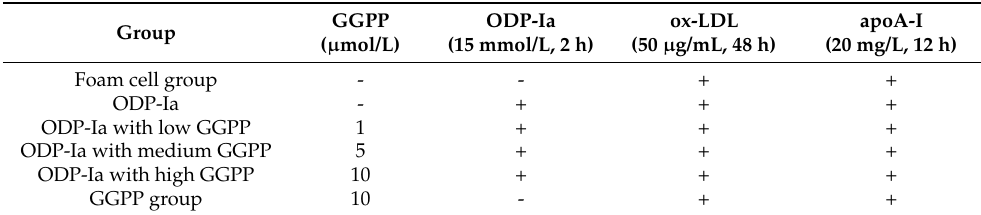
Table 2. Scheme of the study on the effect of GGPP on cholesterol efflux and its associated gene expression in foam cells treated with